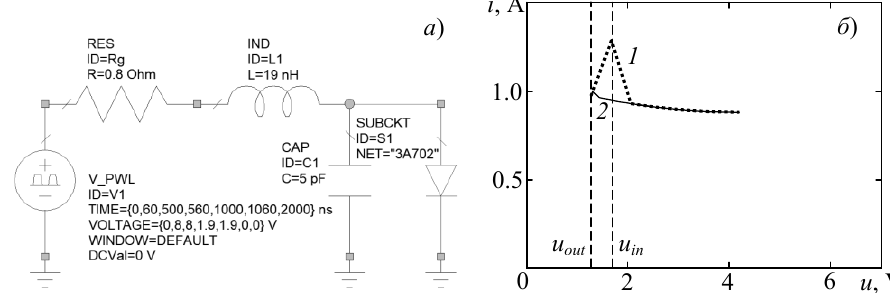
Fig. 6. The measuring circuit model in the NI AWR Design Environment ( a ) and the calculated I-V characteristic of the Gunn diode 3A702 ( b ) at inductances of the connecting circuit of 30 nH ( 1 ) and 19 nH ( 2